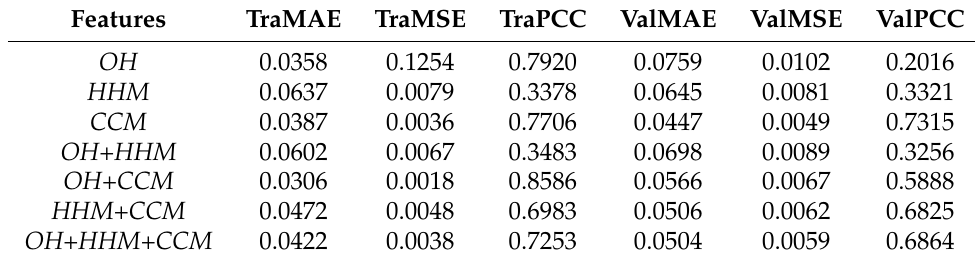
Table 1. Prediction performance based on individual input features and their various combinations 1 .